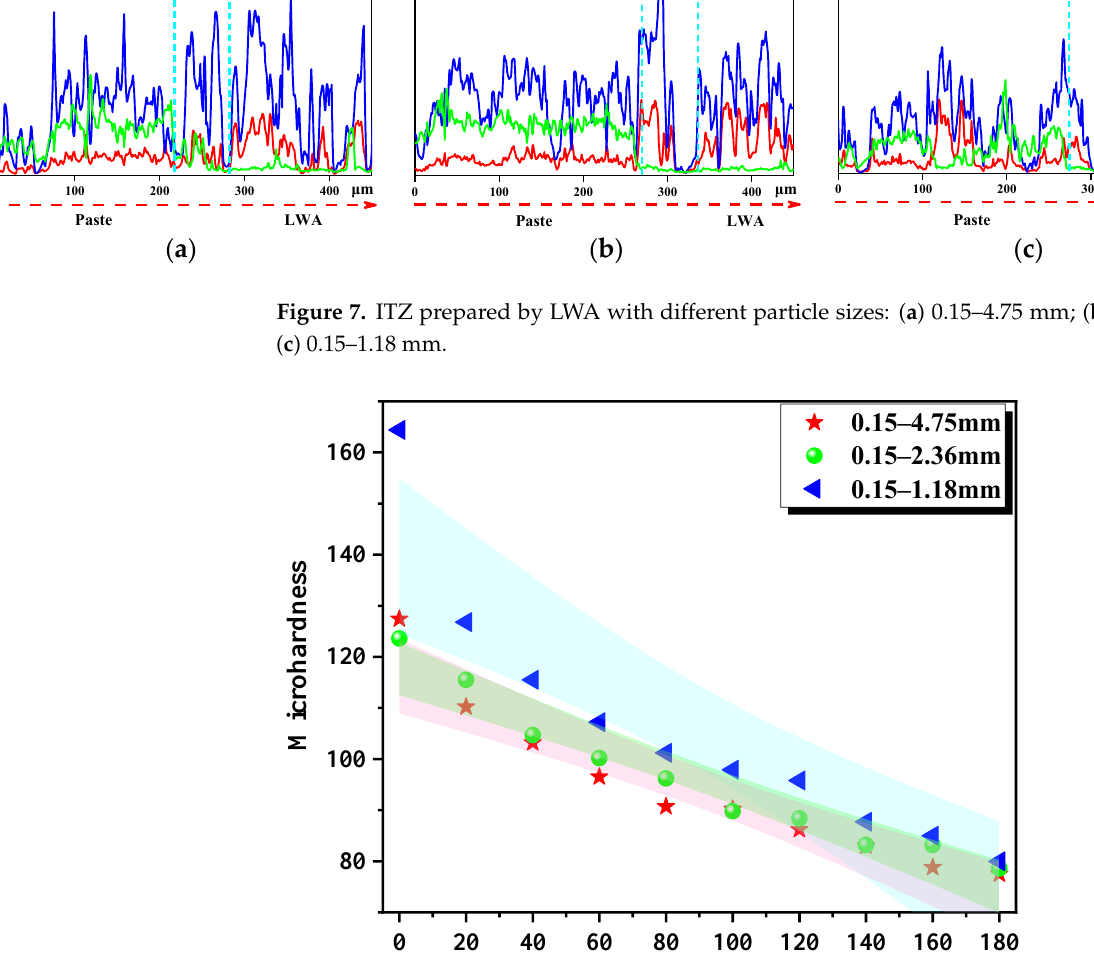
Figure 8. Microhardness of LWA-ITZ-hardened cement paste of LWA with different particle sizes. Colored bands represent 95% confidence band.